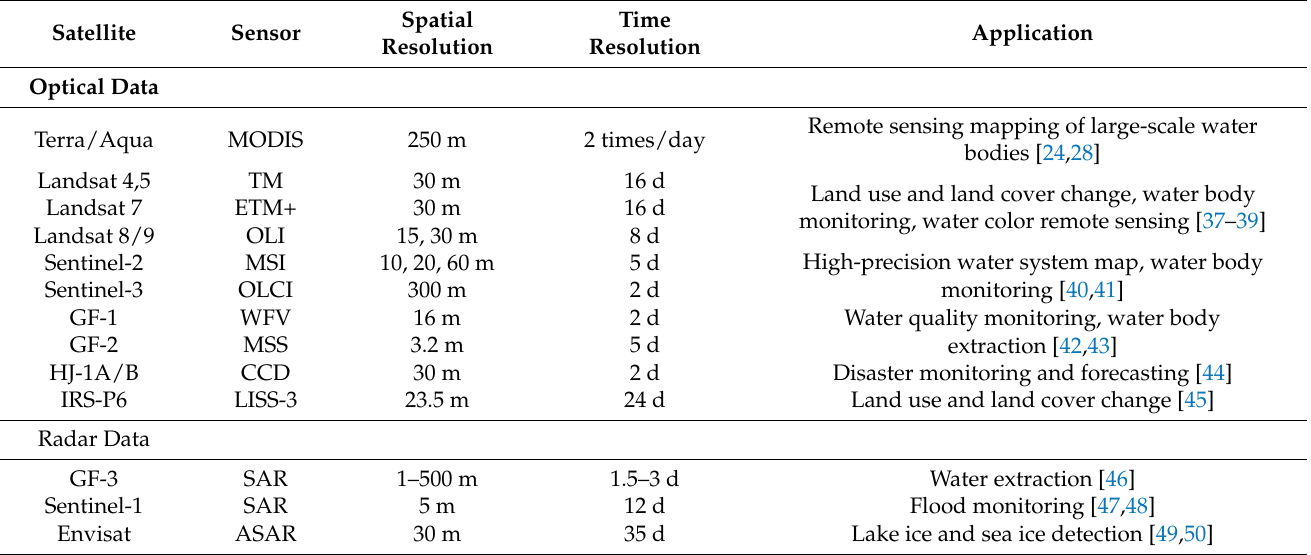
Table 2. The typical data sources for water body